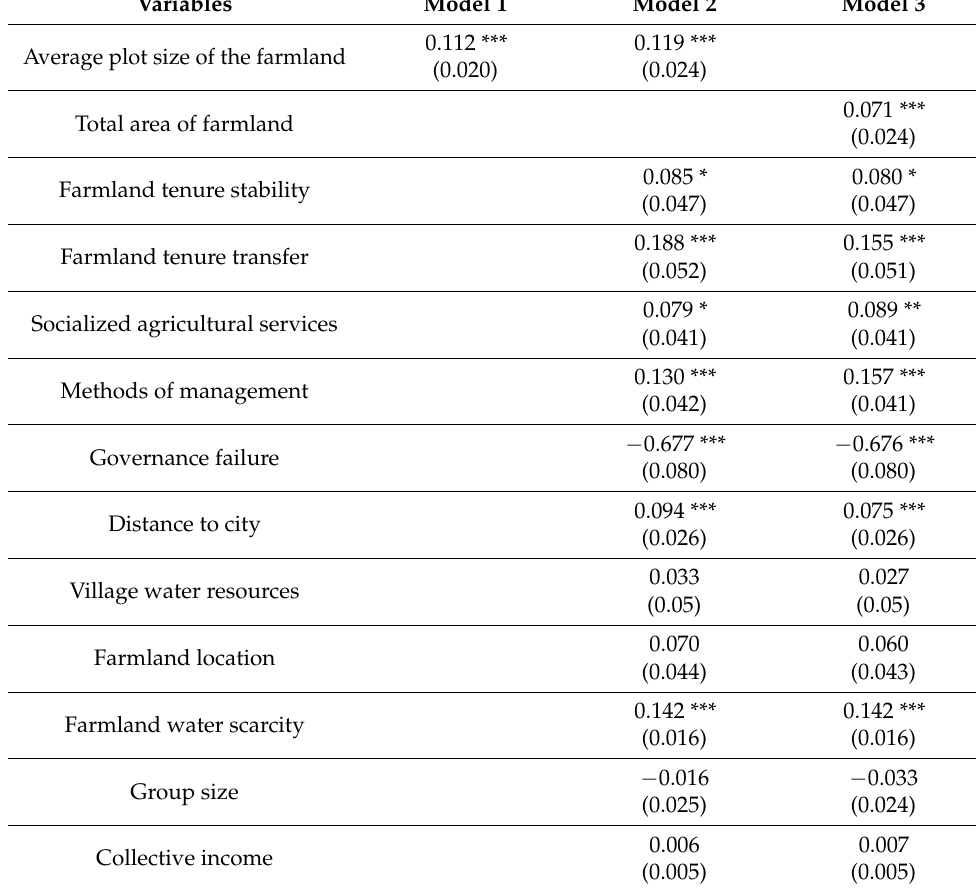
Table 3. Results of direct